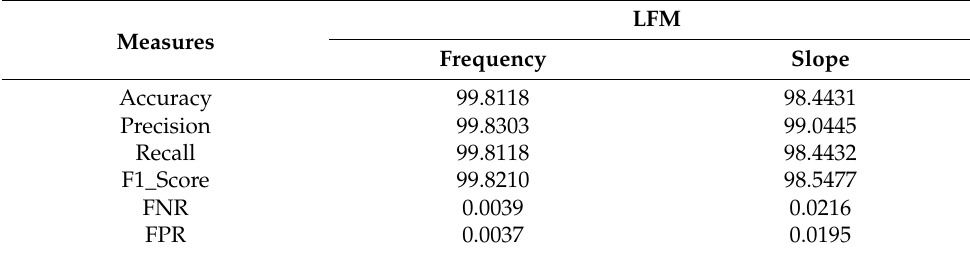
Figure 20. A confusion matrix of SE for LFM. Table 1. Measures of FE and SE for noisy LFM signals.